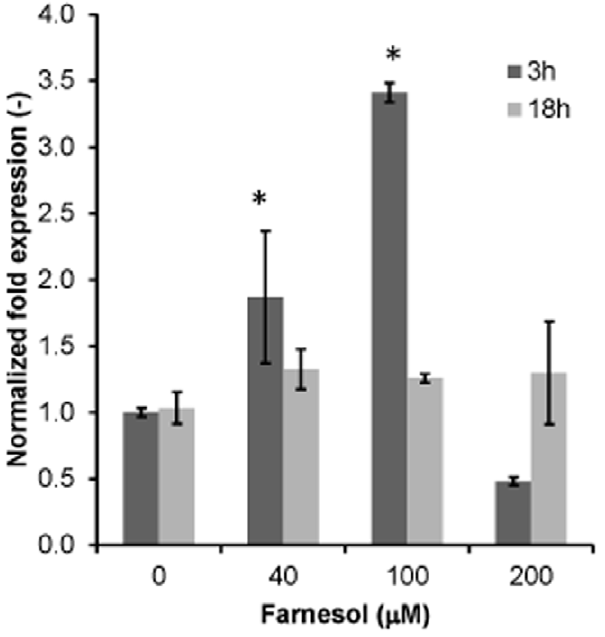
Figure 1. Effect of farnesol on the expression of CDR1 in CA following 3 and 18 h exposure to increasing concentrations of farnesol. Farnesol-concentration and exposure time-dependent up- regulation of CDR1 . Expression is normalized against ACT1 expression. Data represent the average of 3 independent experiments performed in triplicate. Error bars indicate the standard errors of the means. p , 0.05.